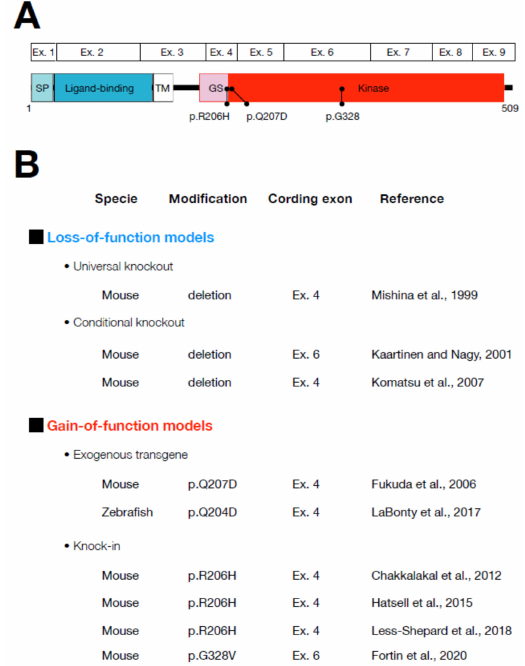
Figure 5. Animal models established by modifying the ALK2/ACVR1 gene: ( A ) Schematic rep- resentation of the ALK2/ACVR1 protein and coding exons (Ex.). ( B ) Animal models in mice and zebrafish have been established to study the physiological functions and pathological changes of ALK2/ACVR1. They are classified in loss-of-function and gain-of-function models. Animal species, modifications, modified target coding exons, and references are